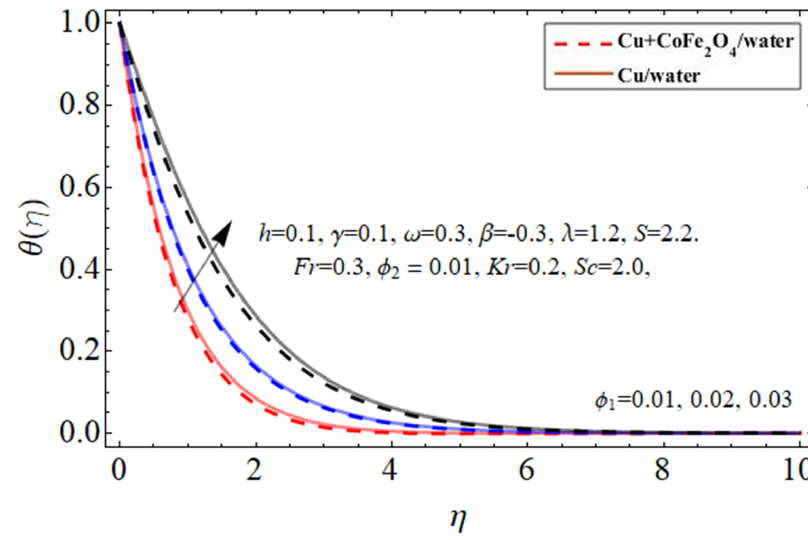
φ φ nanoparticles. nanoparticles.